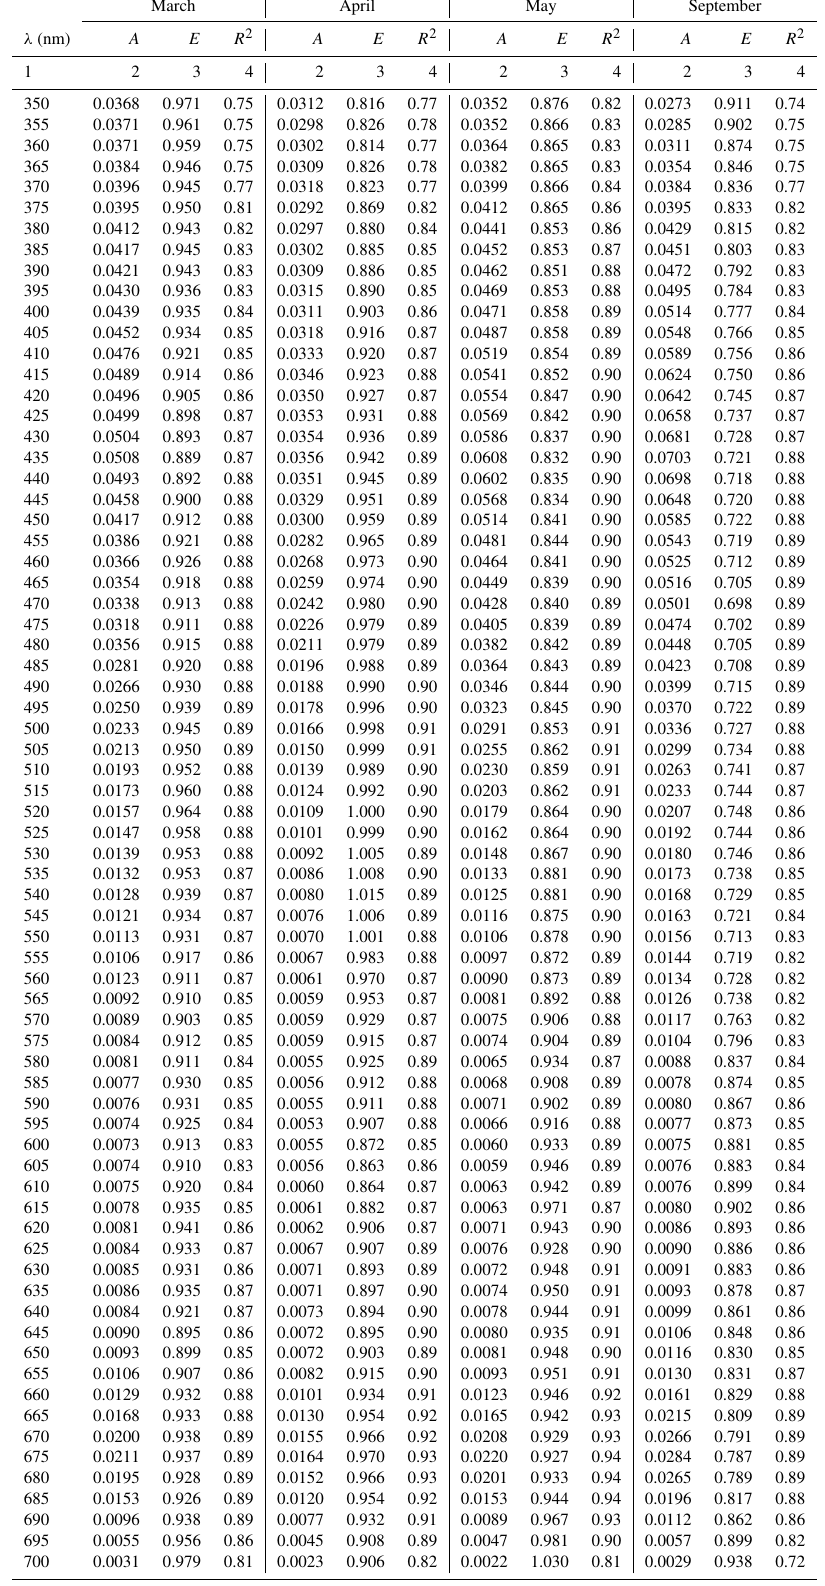
Table A2. Spectral coefficients A and E of the one-component parameterization described by Eq. (3a) in its variants obtained in selected months and the corresponding determination coefficients R 2